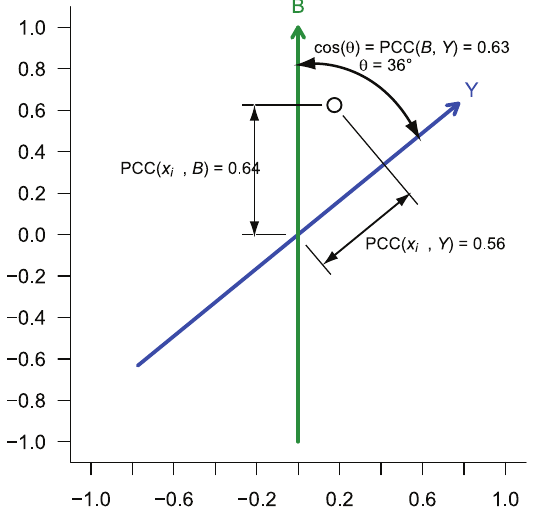
Figure 1. Interpretation of the ‘‘biasogram’’. The biasogram is an orthogonal projection of a gene expression matrix onto a plane defined by previously defined vectors quantifying an outcome Y and bias B for each patient. Each point represents a gene, or probe set. Y and B define axes for a skew coordinate system in which the position of each point indicates its Pearson correlation coefficient with Y and B , respectively. The angle between Y and B represents the correlation between Y and B . For the sake of explanation, only a single gene is represented in this figure. In general, a biasogram for many thousands of genes can be represented by a heatmap rather than by individual points. PCC, Pearson correlation coefficient.